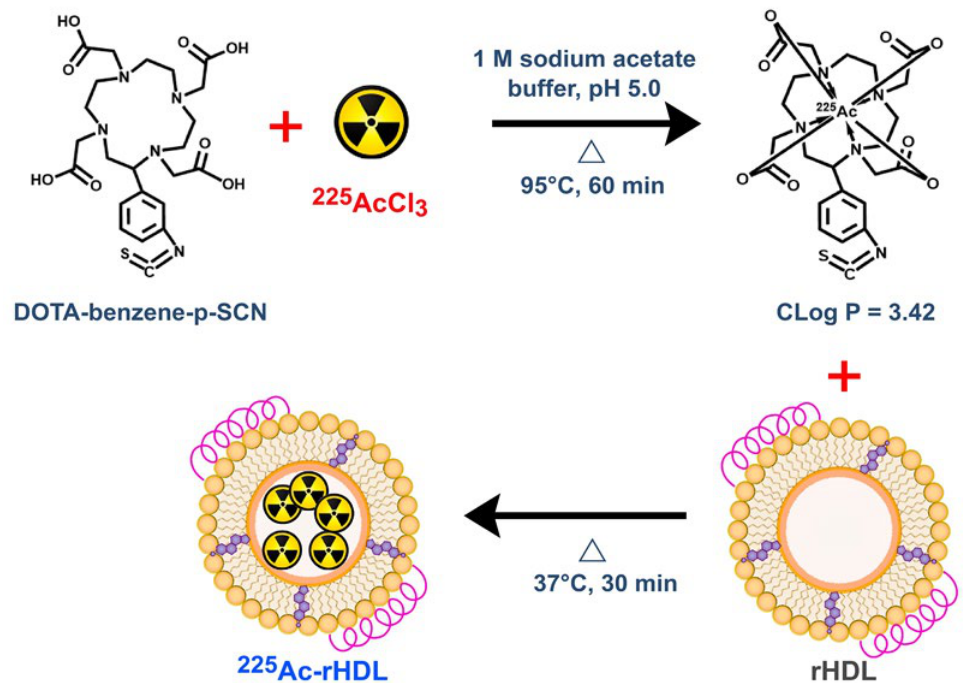
Figure 3. Schematic steps of the incorporation of 225 Ac into rHDL nanocapsules ( 225